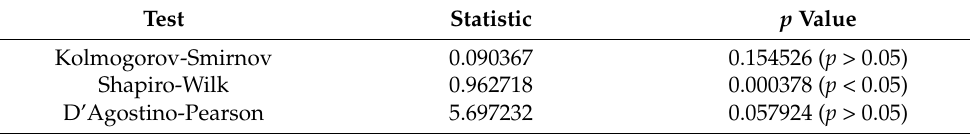
Table 2. Statistical tests for normality (right side of arch support